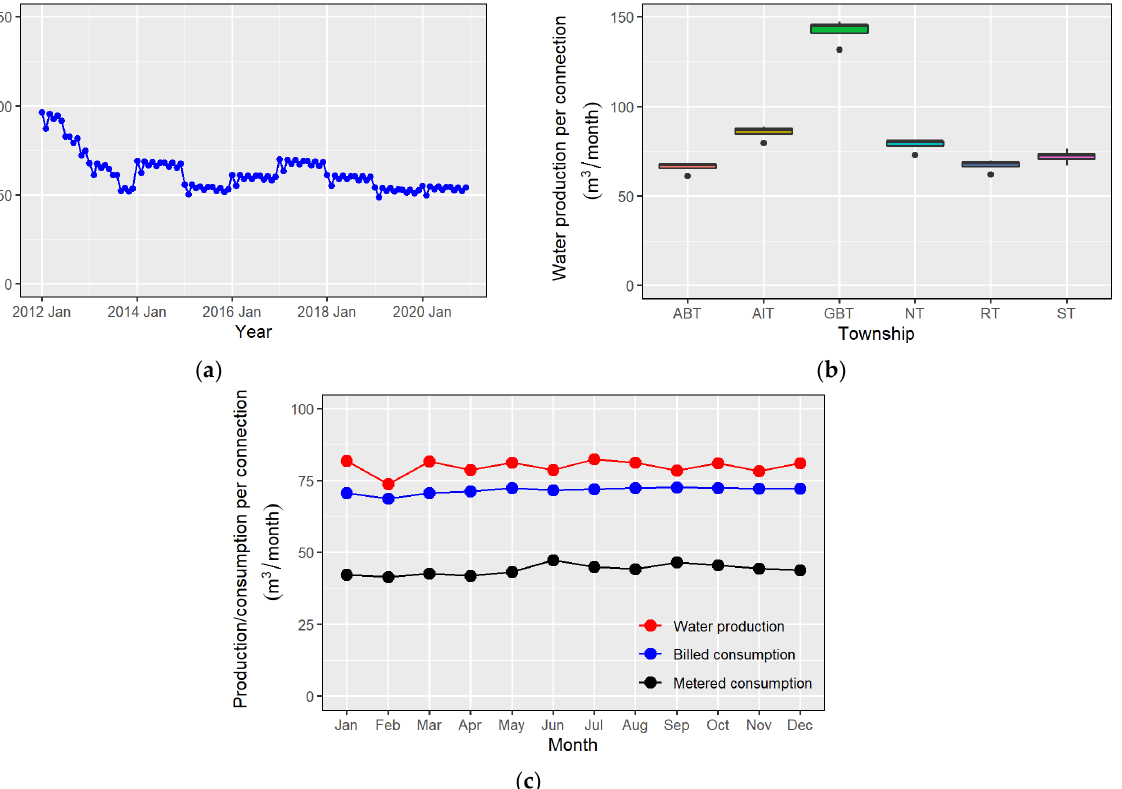
Figure 5. Water production per connection: ( a ) time-series in Tajpura; ( b ) for the six townships in 2020; and ( c ) monthly variations in production, billed consumption, and metered consumption for WASA Lahore in 2020, based on data of the six townships.